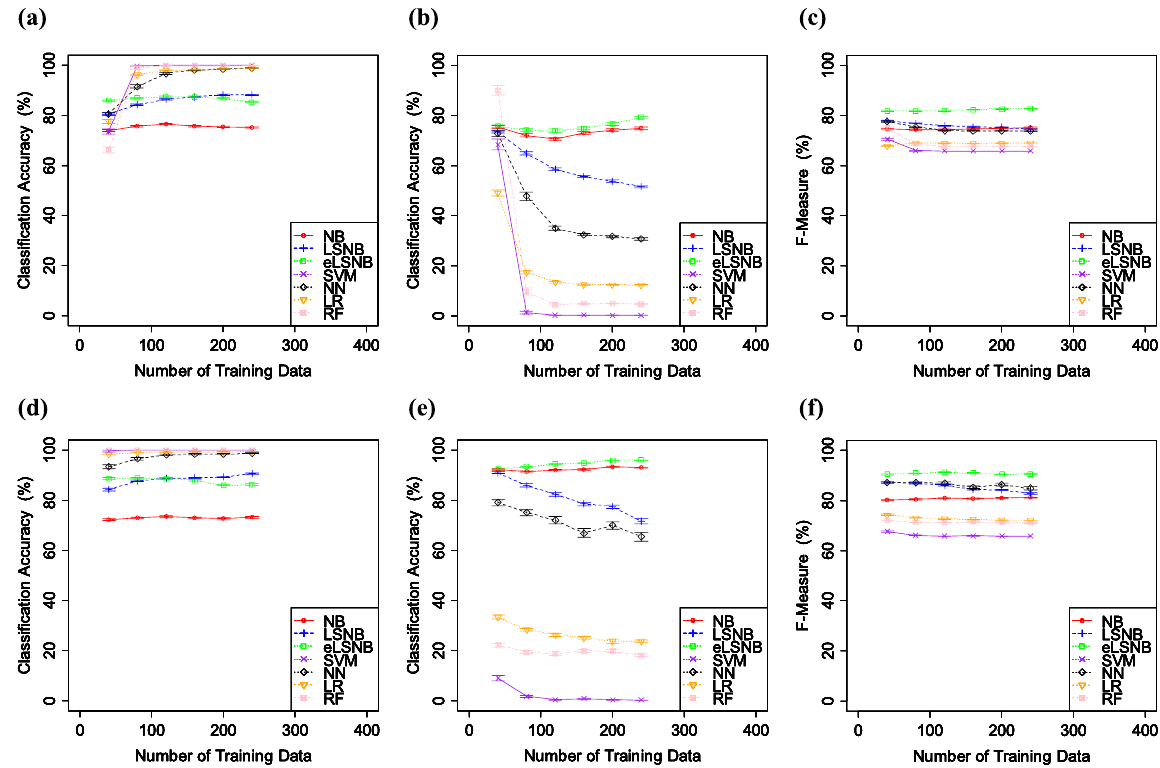
Figure 8. ( a ) spam classification accuracy, ( b ) ham classification accuracy and ( c ) F-measure values for SpamAssassin. ( d ) spam classification accuracy, ( e ) ham classification accuracy and ( f ) F-measure values for Ling-Spam. The number of ham training data points was predefined as 25. Error bars indicate the standard